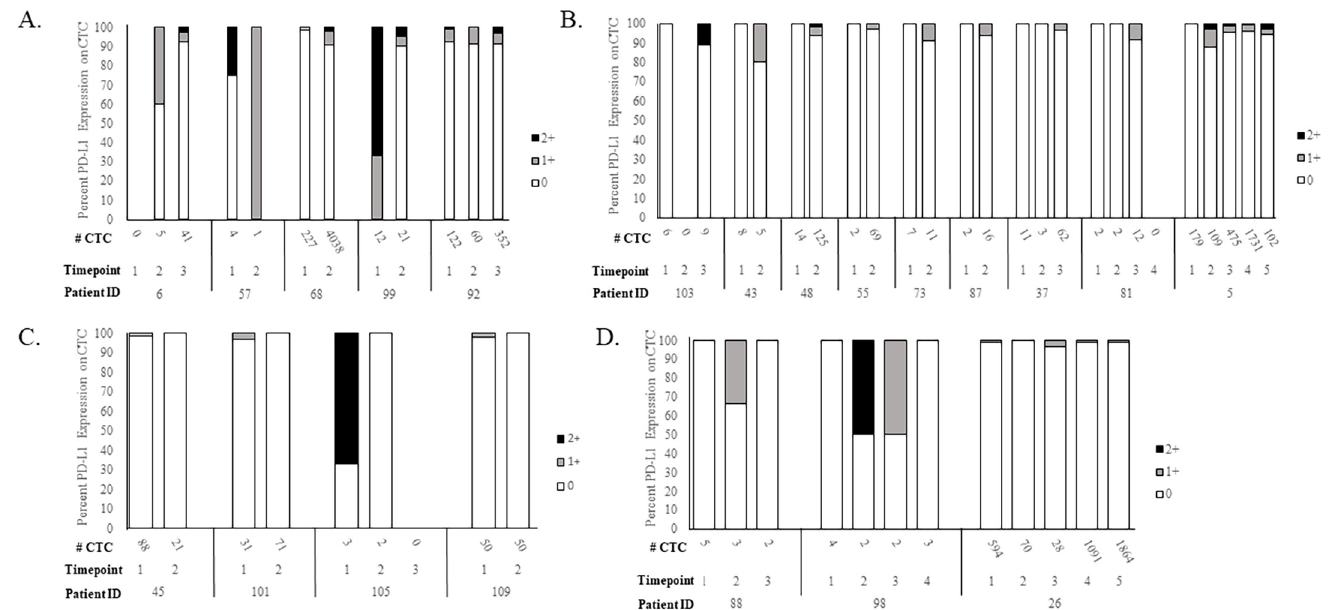
Fig 3. CTC PD-L1 expression at serial timepoints. Whole blood from serial specimens from the same patients was processed through CellSearch 1 with PD-L1 staining in the 4th channel. Each stacked bar represents distribution of CTC PD-L1 staining as described in Fig 1. Patients in each category are separated by a vertical line. A. Patients (N = 5) that maintained CTC PD-L1 positivity from timepoint-1 to subsequent timepoints. B. Patients (N = 9) that converted CTC PD-L1 negative to positive from timepoint-1 to subsequent timepoints. C. Patients (N = 4) that converted CTC PD-L1 positive to negative from timepoint-1 to subsequent timepoints. D. Patients (N = 3) that had fluctuating CTC PD-L1 expression among multiple timepoints.